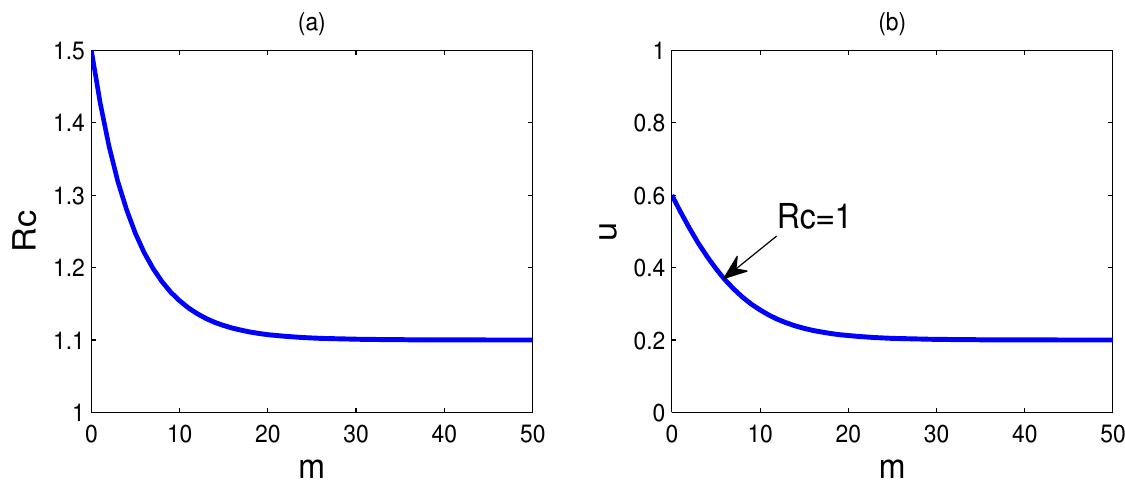
Figure 2. ( a ) The plot of the control reproduction number R where u = 0 and other parameters assume the values of Table 1; ( b ) the plot for which R equal to one. Every parameter point ( m, u ) that corresponds to R and R > 1 for those points that lie below the R c